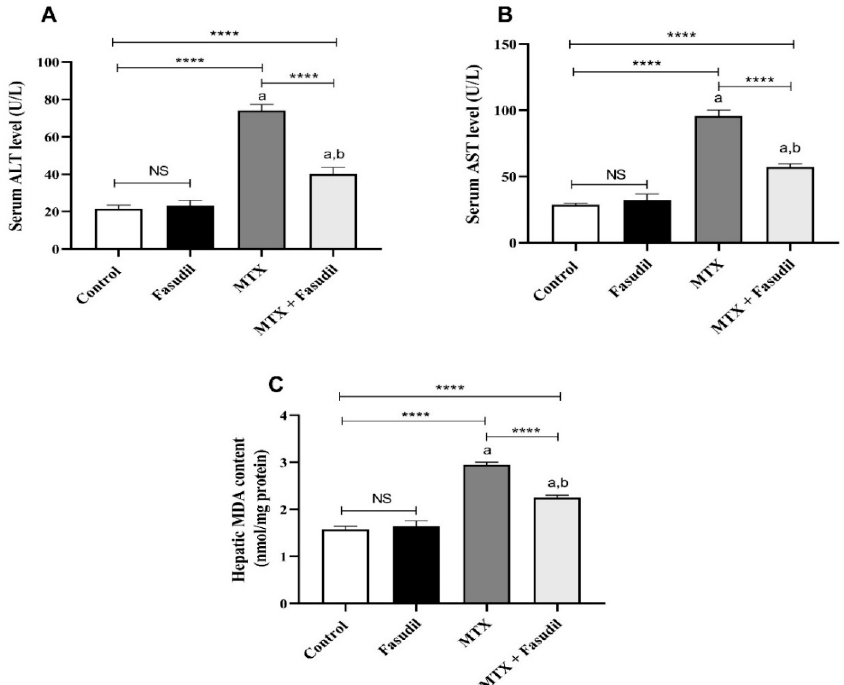
Figure 2. Effect of fasudil on hepatic enzymes and lipid peroxidation after MTX challenge: ( A ) serum ALT; ( B ) serum AST; ( C ) hepatic content of MDA. Results are presented as mean ± SEM ( n = 8); a: significant difference from the control group ( p < 0.05); b: significant difference from the MTX control group ( p < 0.05). **** p < 0.0001. NS, non-significant.